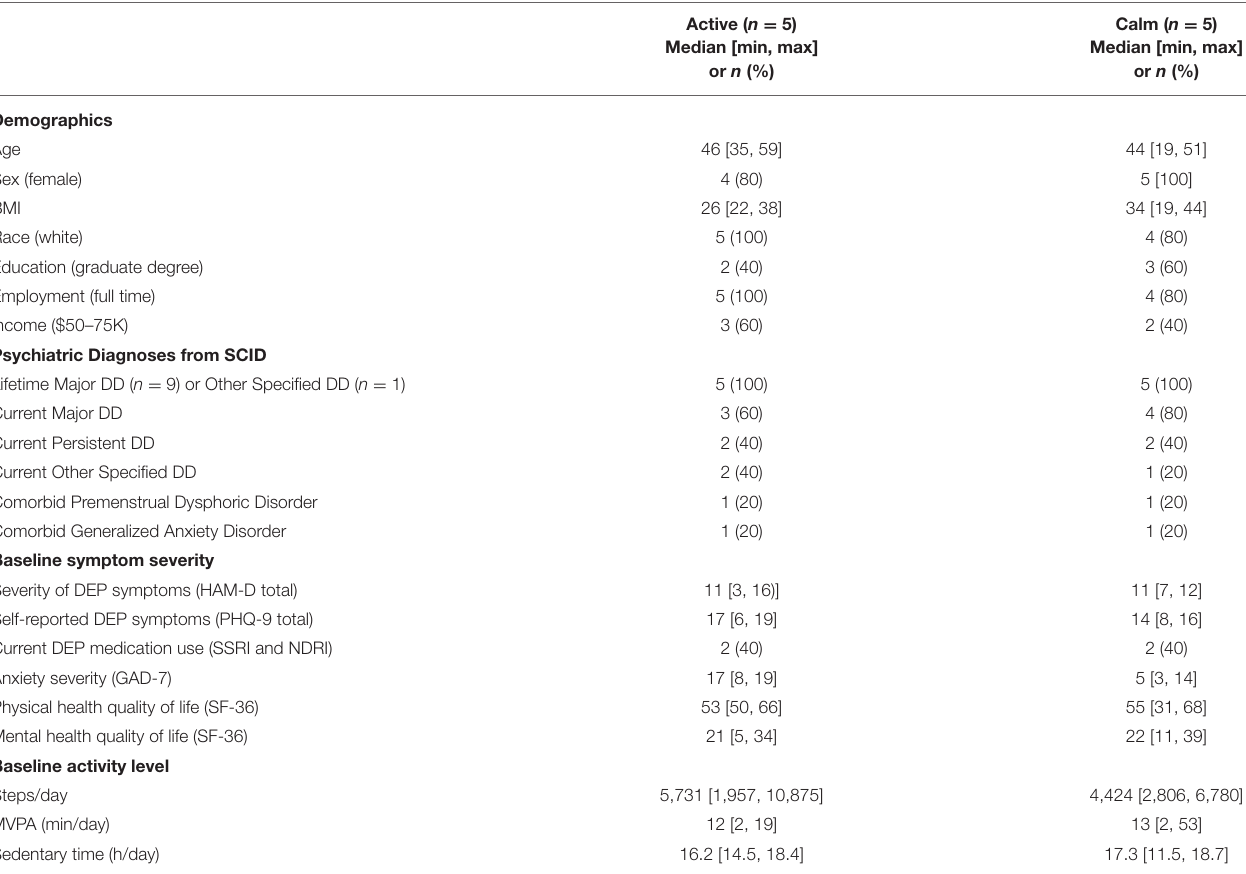
TABLE 1 | Participant